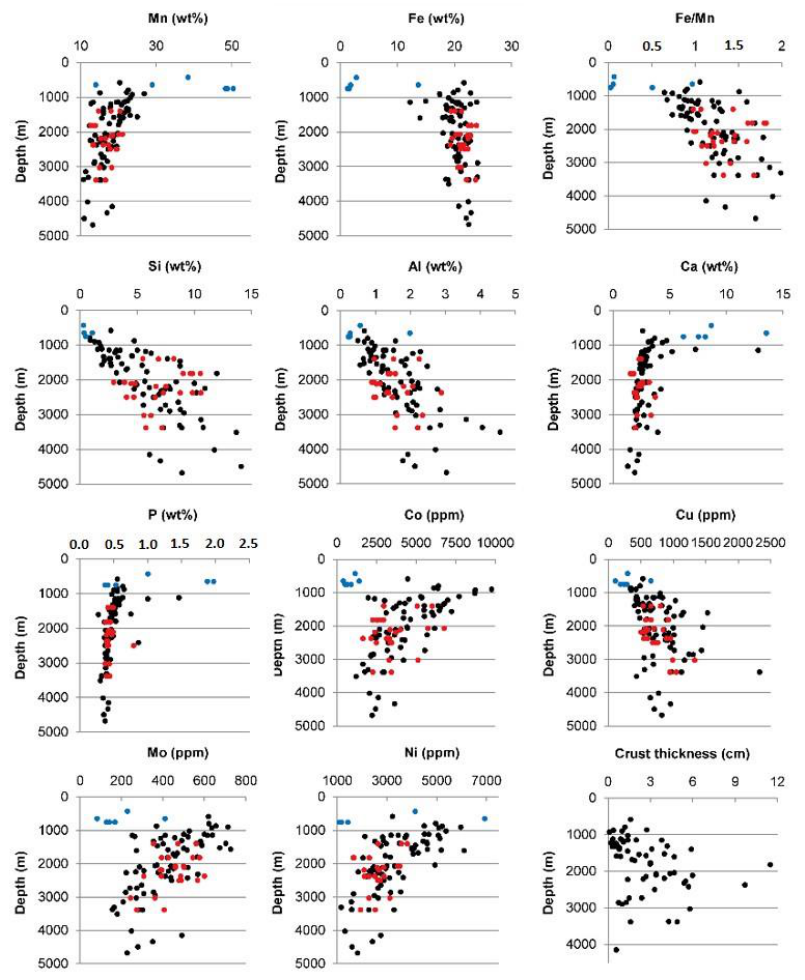
Figure 11. Repartition of selected elements with water depth. Black dots are the bulk crusts ( n = 74), red dots are the macro-layers crusts ( n = 24), and blue dots are the non-hydrogenetic deposits. Graph of crust thickness only considers bulk crusts with a measurable/known thicknes.